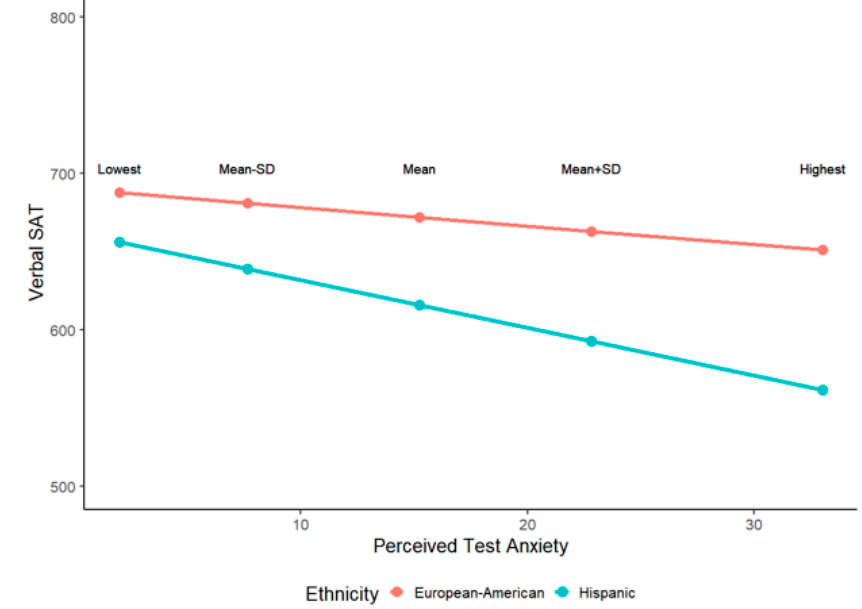
Figure 4. Reproduced visualization of verbal SAT scores as a function of ethnicity and test anxiety, and their interaction when controlling for cognitive abilities, performance-avoidance, metacognitive awareness, and SES.